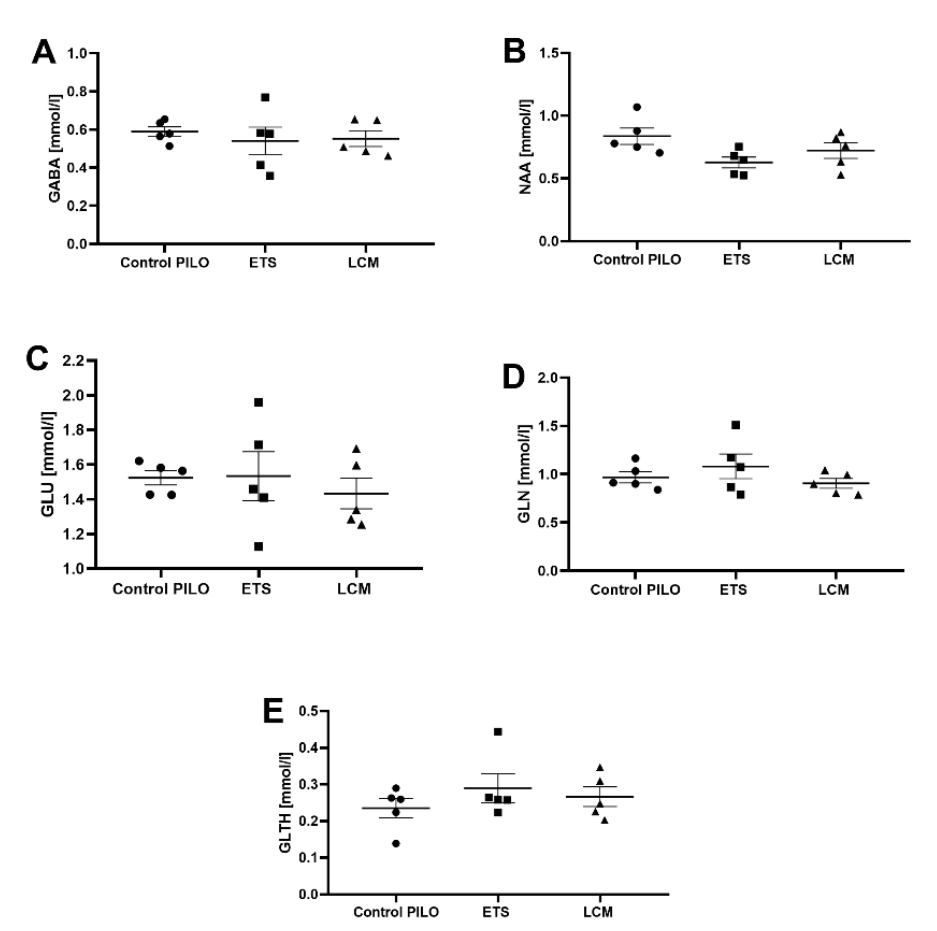
Figure 6. Evaluation of the long-term LCM and ETS administration on the level of ( A ) GABA; ( B ) NAA; ( C ) GLU; ( D ) GLN and ( E ) GLTH in mice after PILO induced SE.